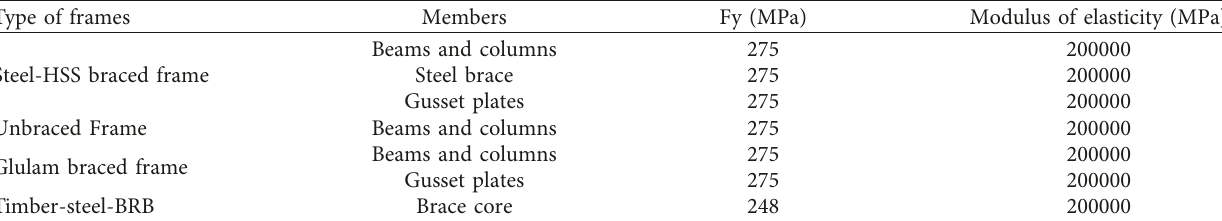
Table 2: Frames members material mechanical Property.